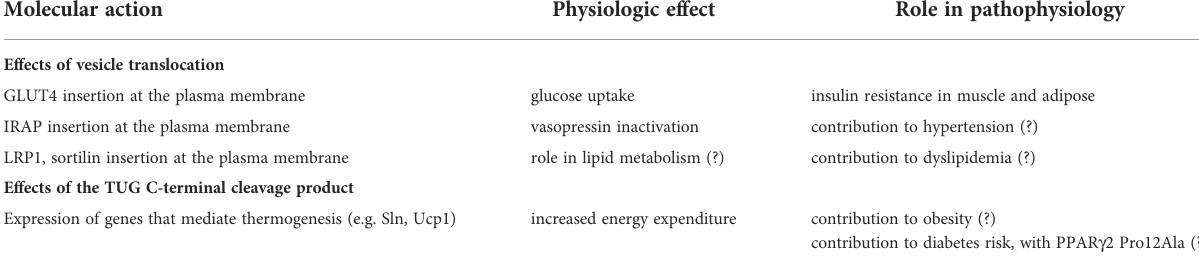
TABLE 1 Physiologic effects of TUG ubiquitin-like proteolytic